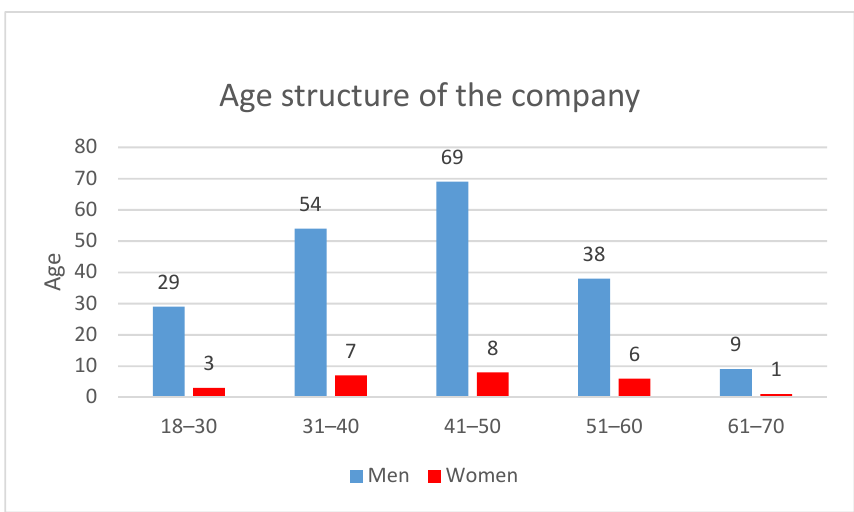
Figure 2. Illustration of the company age structure. Source: authors.